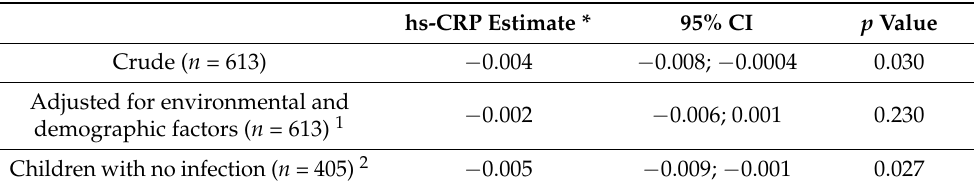
Table 1. The association between log hs-CRP and vitamin D at age 6 months in COPSAC 2010 from uni- and multivariable linear regression models.